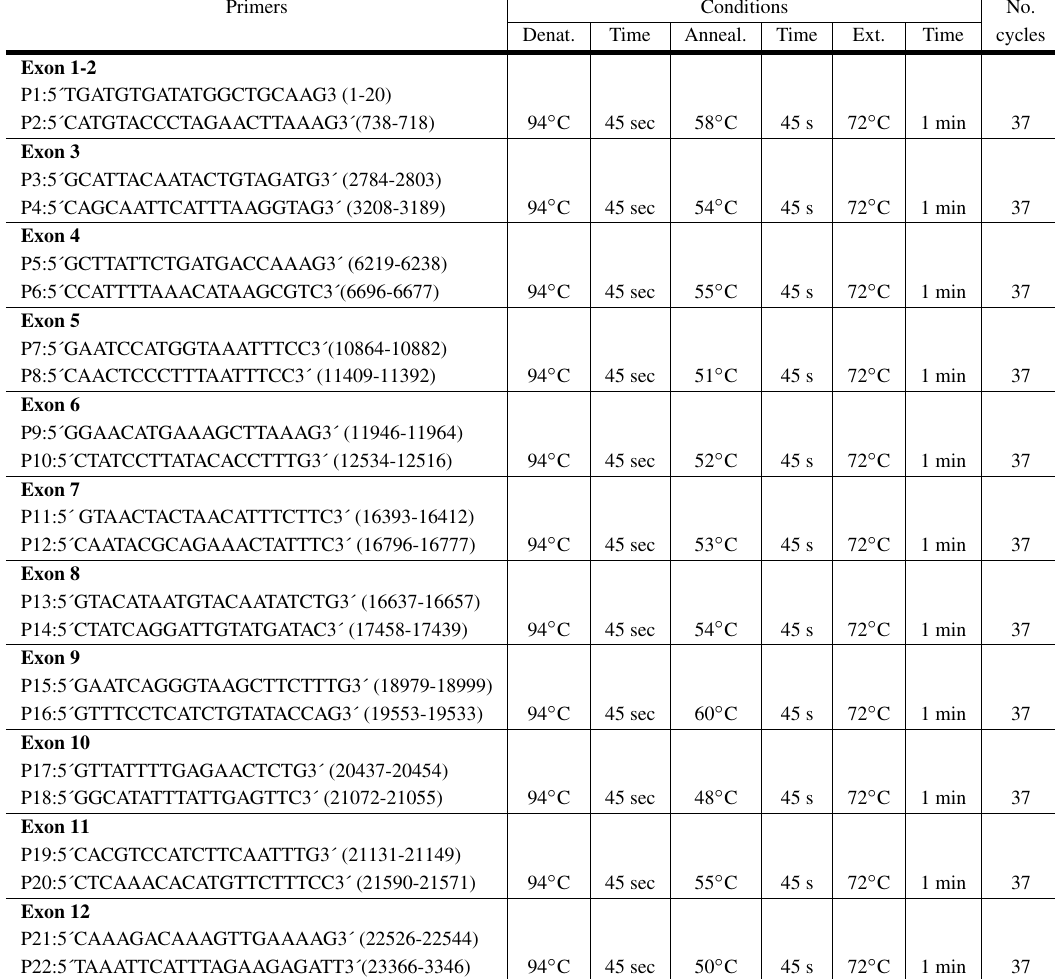
Polymerase Chain Reaction (PCR) amplication conditions and primers sequences. The temperature, time of each PCR step, number of PCR cycle, and primers used to amplify the different exons of CLCN5 are shown. Denaturation (Denat); Annealing (Anneal); Extension (Ext.). Primers Conditions No. Denat.